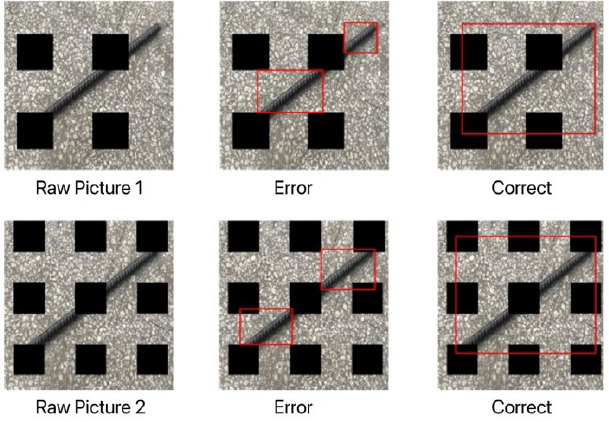
Figure 24. Bounding box annotations for occluded images.